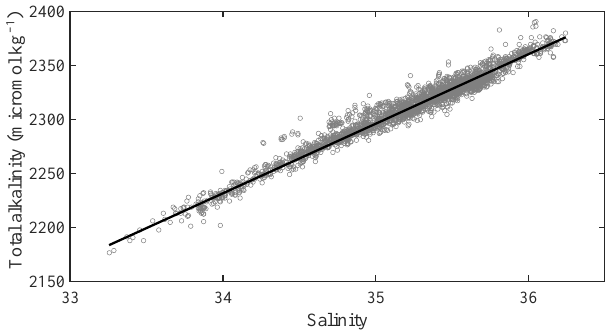
Figure 2. The new salinity–alkalinity relationship developed for the Australian region based on observations (Fig. 1) collected in the period 1992–2011. The individual cruises are listed in Table 1.